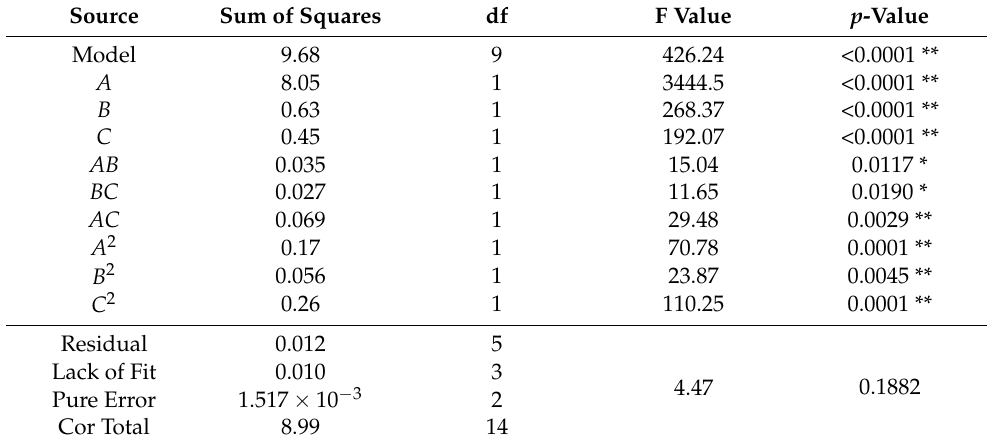
Table 5. Variance analysis of the conveying